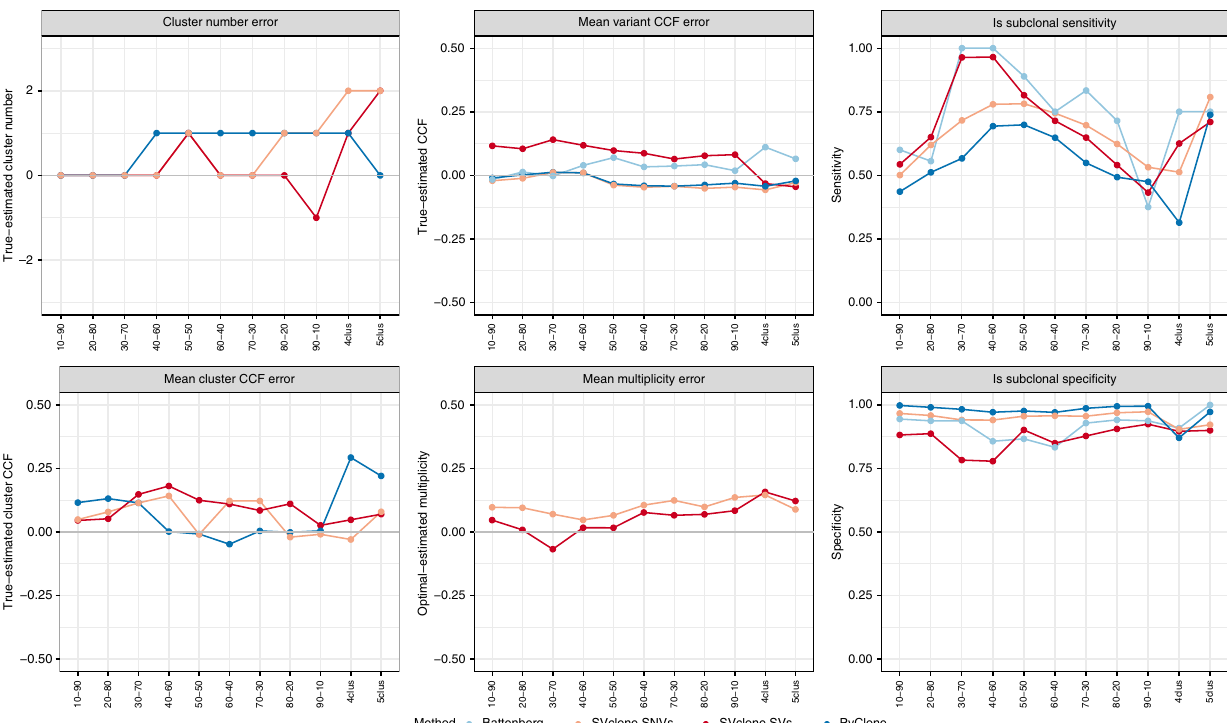
Fig. 3 Clustering performance metrics versus existing methods. Performance of SVclone ’ s SV and SNV models, compared with Battenberg (SCNAs) and PyClone (SNVs) run on the in silico mixtures. The fi rst column shows the cluster number error (three-inferred cluster number), and the mean CCF error, where true and inferred clusters are matched based on their order (see Methods). The second column shows the mean variant CCF and multiplicity error compared with the ground truth CCF. The third column shows the subclonal classi fi cation sensitivity and speci fi city using sample membership of the variant (i.e. a variant is classi fi ed as clonal if present in both samples of the mixture, and subclonal